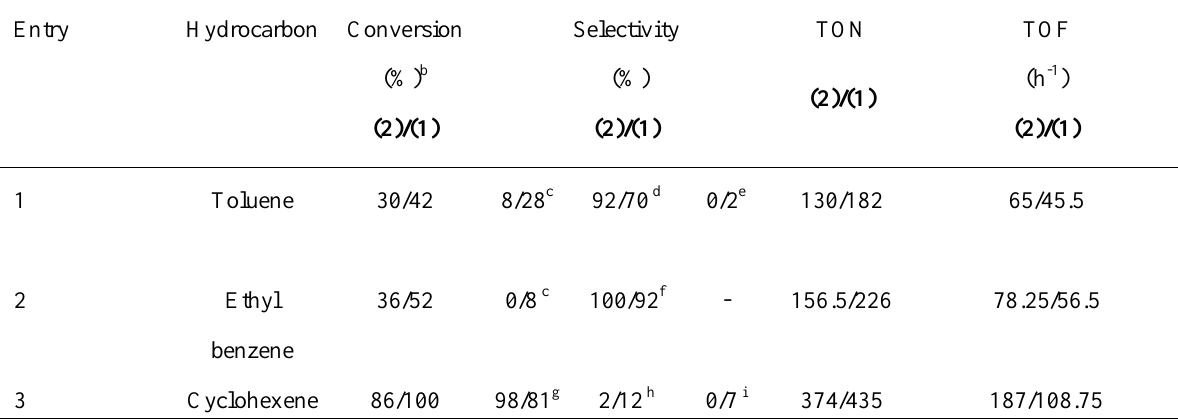
O @SiO /CPTMS/[Cu(tyr) 3 4 2